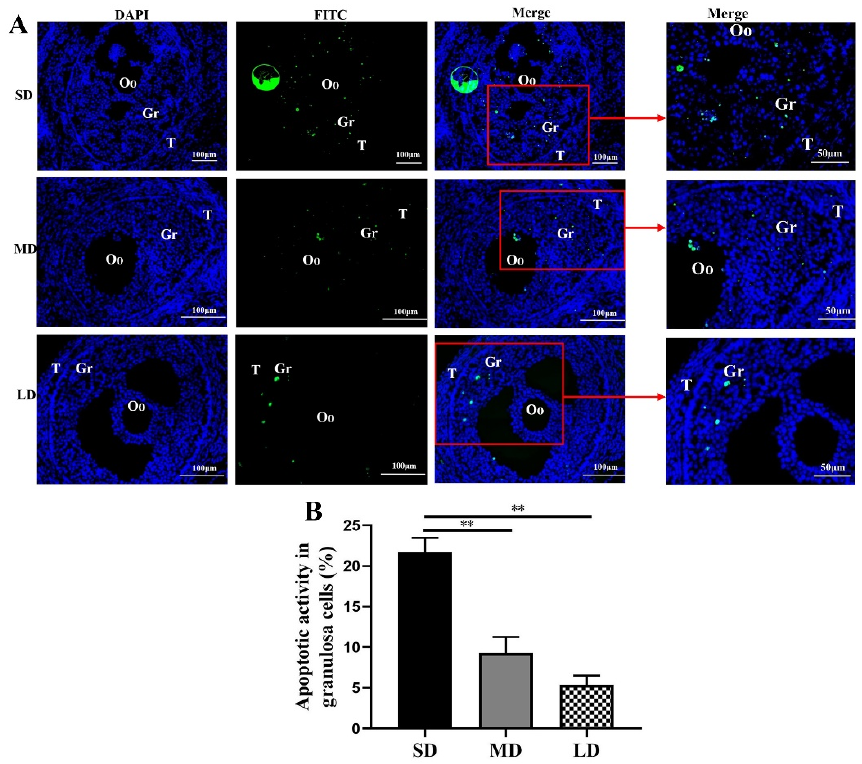
Figure 4. TUNEL detection results of the ovary tissue in Phodopus sungorus under three photoperiod conditions. ( A ) Fluorescent TUNEL staining of the ovaries of Phodopus sungorus under three photoperiod conditions. Blue, nuclei stained with 4 ′ , 6-diamino-2-phenylindole (DAPI); green, TUNEL results of the FITC. The area indicated by the red arrow is an enlarged image of Merge. ( B ) Apoptosis activity of the granulosa cells in Phodopus sungorus under three photoperiod conditions. Bar = 100 µ m; n = 3. Oo, oocyte; Gr, granulosa cells. SD, short daylight; MD, moderate daylight; LD, long daylight, ** p < 0.01.